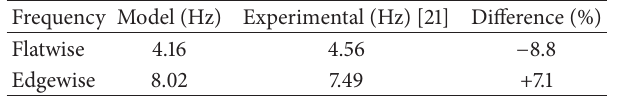
Table 2: Comparison of model and experimental